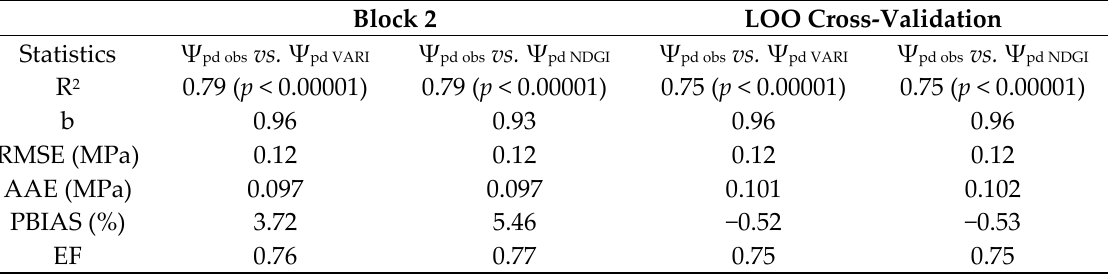
Table 3. The goodness-of-fit indicators relative to predicting Ψ pd with visible atmospherically resistant index (VARI) opt , normalized difference greenness vegetation index (NDGI) opt when testing the prediction equations with data of block 2 ( n = 30) and applying leave-one-out (LOO) cross-validation ( n = 30).